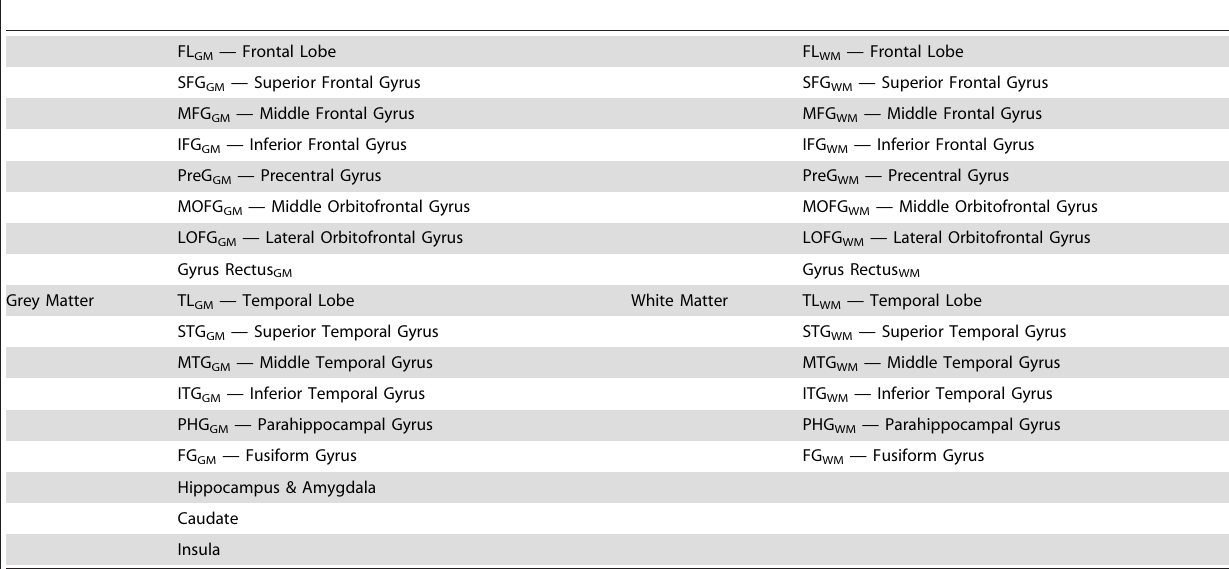
Table 2. Anatomical Structures Selected for Volumetric Analyses, based on the LPBA40